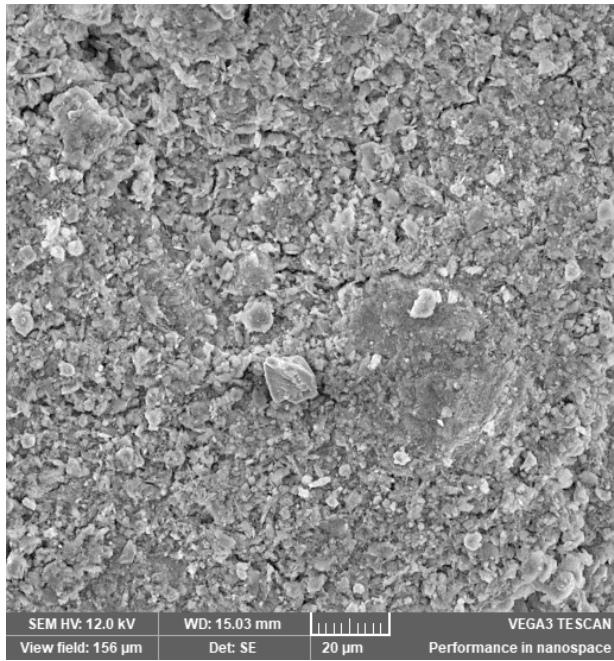
Figure 5. The SEM analysis of the zeolite sample NaOH 1.